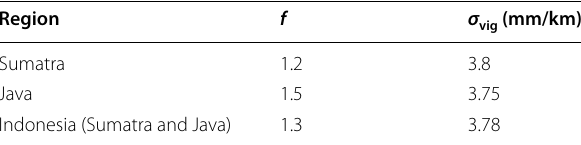
Table 2 The inflation factor ( f ) and σ Java